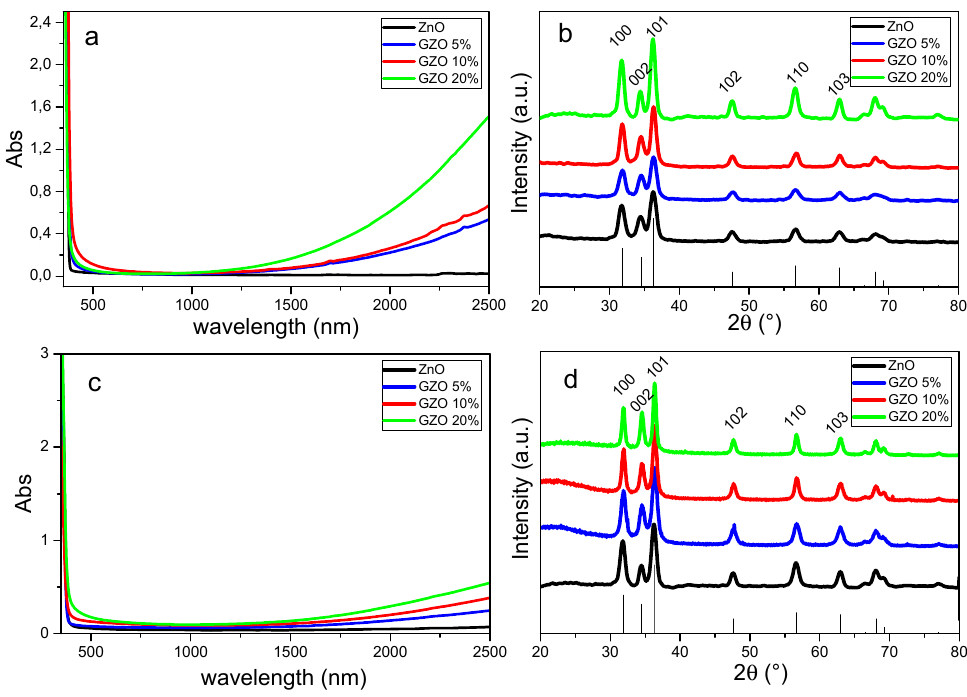
Figure 1. Optical absorption spectra ( a , c ) and XRD patterns ( b , d ) for the as-synthesized GZO NCs ( a , b ) and for thin films after annealing at 450 °C in forming gas ( c , d ) at different nominal gallium doping. The absorption spectra of the NCs in solution are obtained from equimolar colloidal suspensions using TCE as